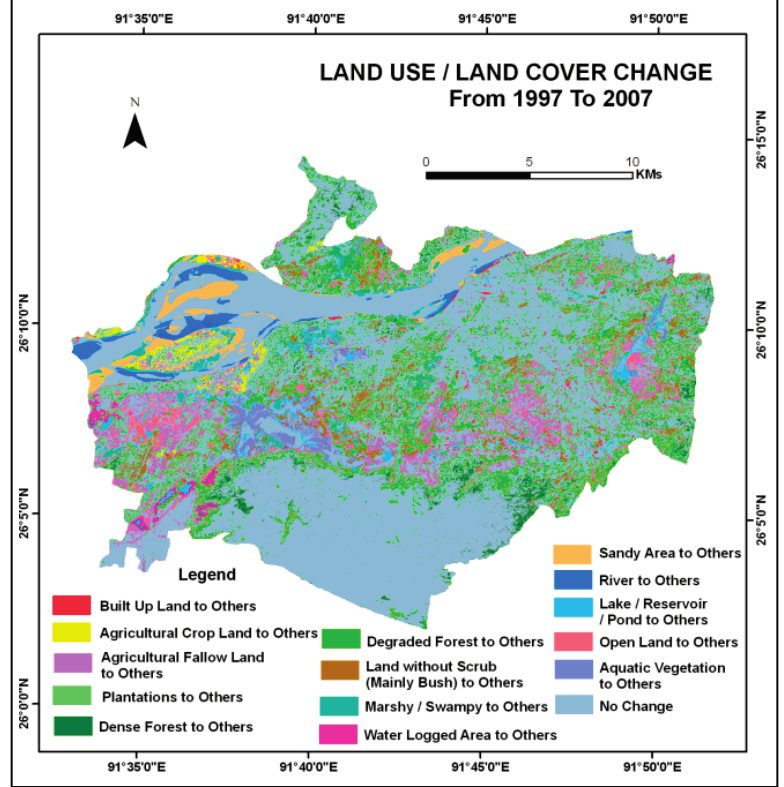
Figure 12. Gross loss of each LULC category during 1997 and